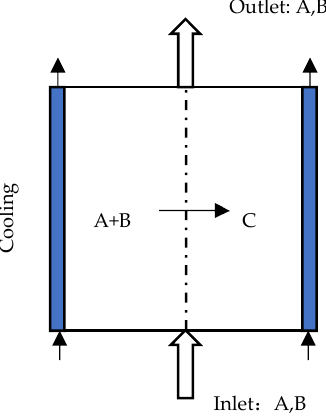
Figure 28. Tubular reactor.